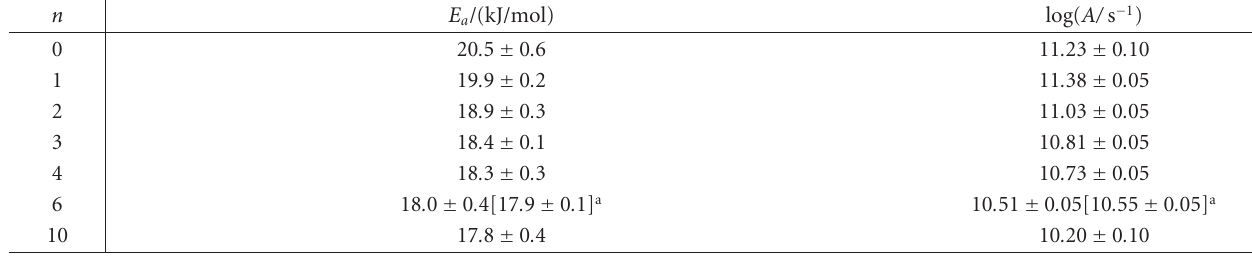
Table 4: Dependence of the activation energies and pre-exponential factors for loop formation on the length of Trp-(Gly-Ser) n -Dbo-NH 2 peptides in D 2 O.